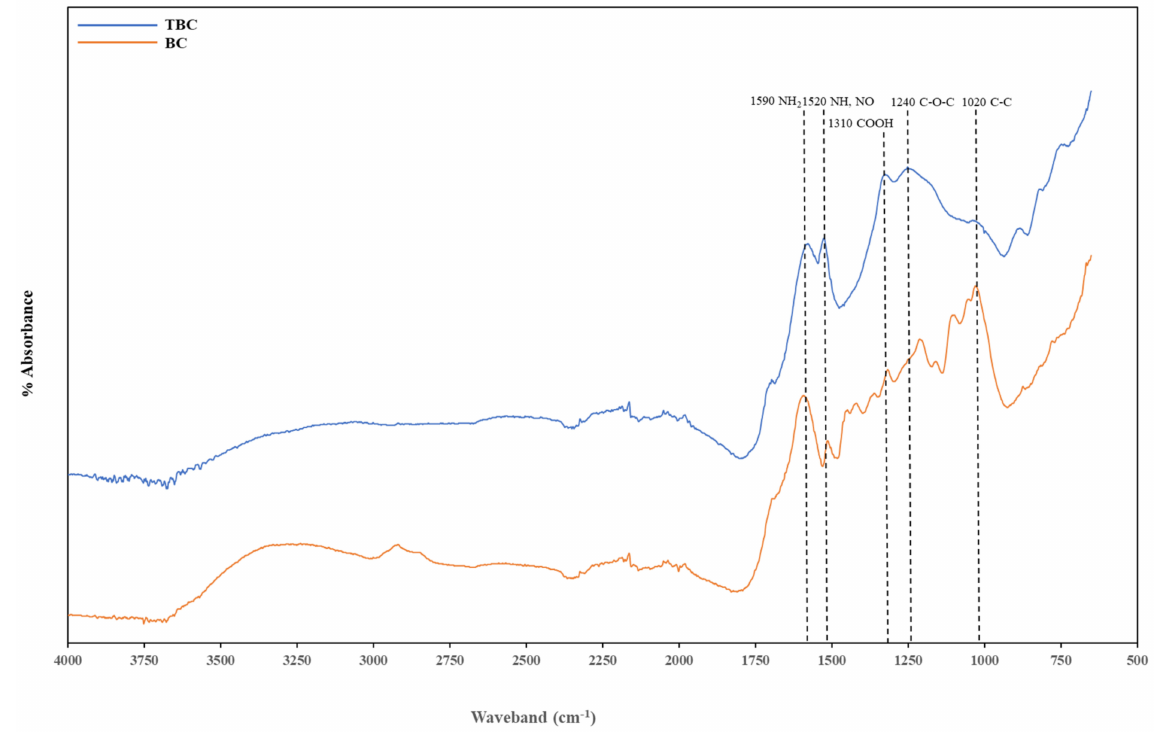
Figure 5. Fourier Transformed Infrared (FTIR) spectra of biochar (BC) and treated biochar (TBC).